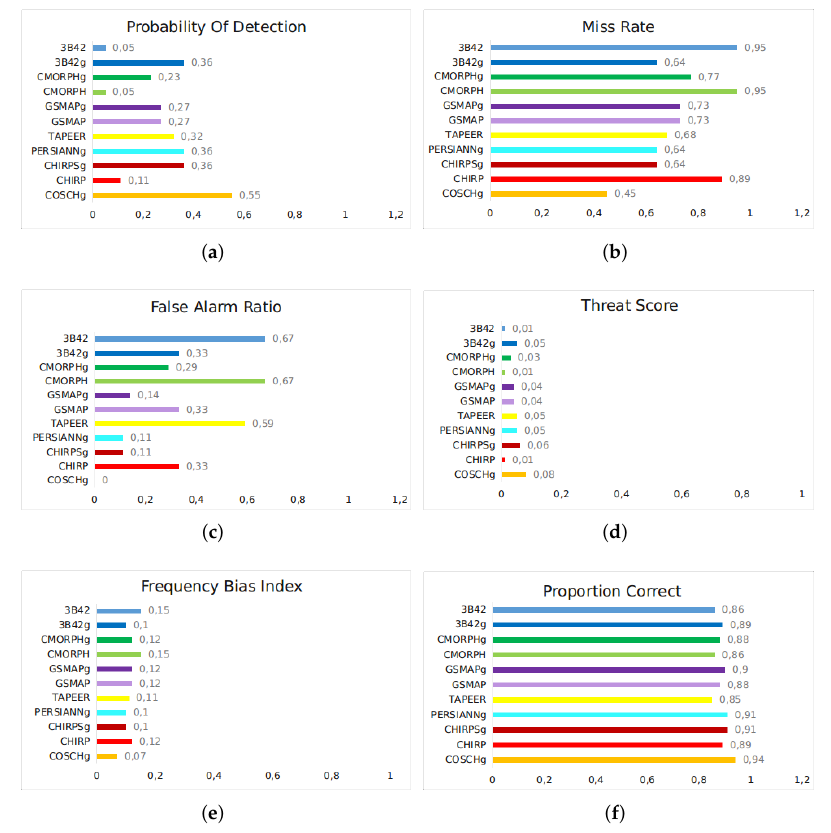
Figure 22. Bar graphs of ( a ) Probability Of Detection (POD); ( b ) Miss Rate (MR); ( c ) False Alarm Ratio (FAR); ( d ) Threat Score (TS); ( e ) Frequency Bias Index (FBI); and ( f ) Proportion Correct (PC) for five days of accumulated precipitation over the north region of Brazil from 29 April 2016 to 3 May